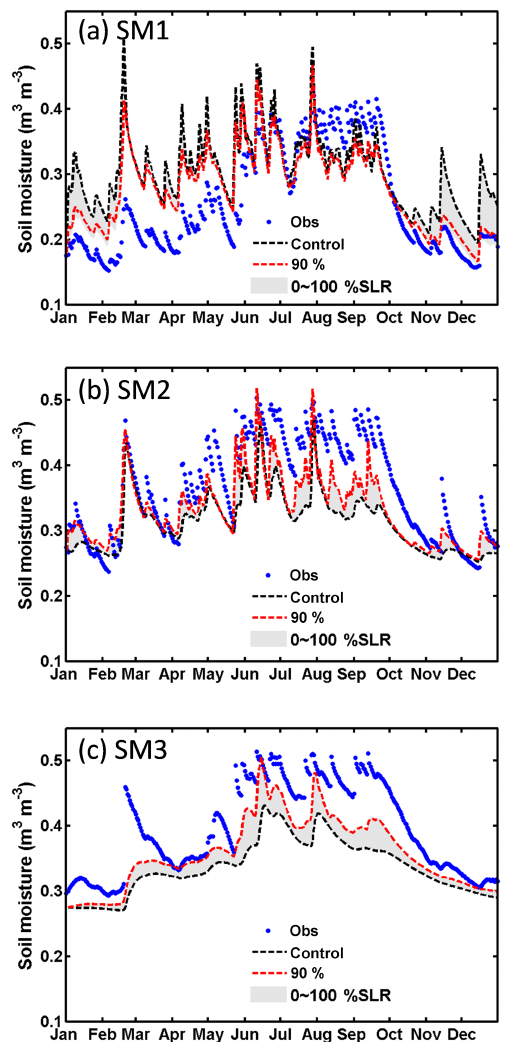
Figure 5. Simulated and observed soil moisture for the LHC site at depths of (a) SM1 (0–20cm), (b) SM2 (20–70cm) and (c) SM3 (70–170cm). Observed results are shown as blue dots. Simula- tions with SLR = 0 (i.e., control run, without stem–root flow) and SLR = 90% are shown as black dashed and red dashed curves, re- spectively. The area of grey shading enclosed by SLR = 0% and 100% indicates the possible range of the stem–root flow effects. All simulation results are daily averages.